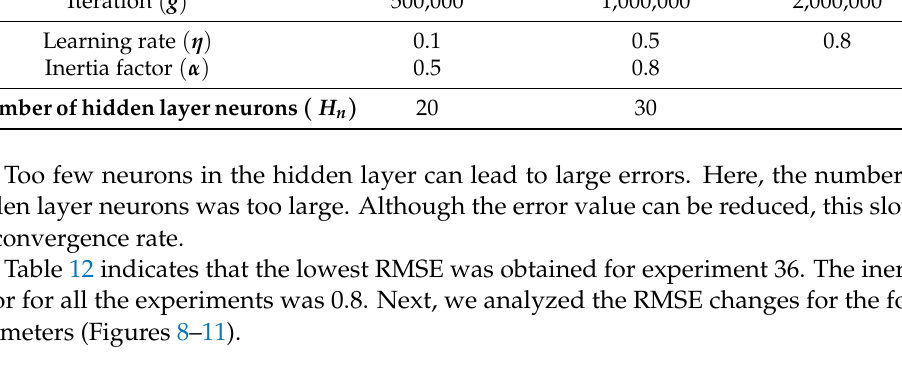
Table 12. BPNN parameter experiment